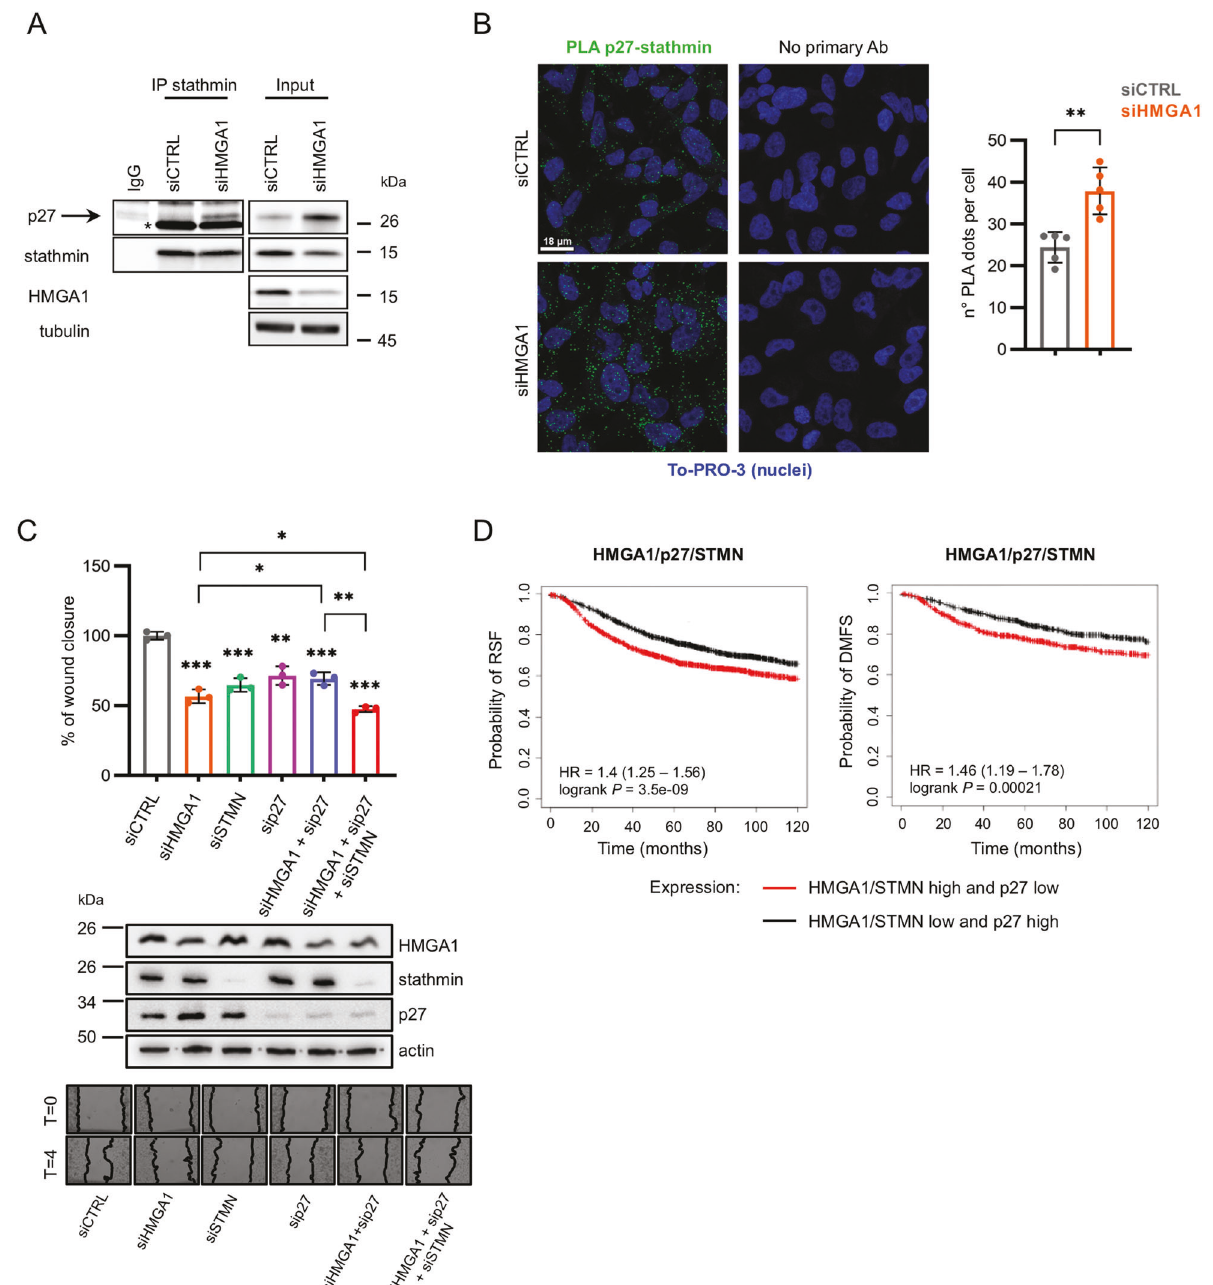
Fig. 5 HMGA1/p27/stathmin axis regulates migration in MDA-MB-231 cells. A Lysates from MDA-MB-231 cells transfected with siCTRL and siHMGA1 were immunoprecipitated with stathmin and non-speci fi c IgG antibodies. The amount of co-immunoprecipitated p27 is visualized by western blot analysis (the speci fi c band is indicated by the arrow). The asterisk indicates the aspeci fi c band due to the presence of immunoglobulines. Inputs are shown on the right. B p27-stathmin proximity was measured by in situ PLA in MDA-MB-231 cells transfected with siCTRL and siHMGA1. In situ PLA is indicated by green signals of the rolling cycle ampli fi cation products. Nuclei (blue) were counterstained using TO-PRO-3. Scale bar, 18 μ M. Quanti fi cation of the number of fl uorescent puncta per cell is shown on the right ( n = 5 different fi elds). ** P < 0.01; two-tailed Student ’ s t -test. C Quanti fi cation of wound-healing assay performed in MDA-MB-231 cells upon silencing of HMGA1 (siHMGA1), stathmin (siSTMN) and p27 (sip27). The results are presented as the mean of percentage of the wound closure relative to control ( n = 3). * P < 0.05, ** P < 0.01, *** P < 0.001; two-tailed Student ’ s t -test. A representative western blot of HMGA1, stathmin and p27 expression after silencing is reported at the bottom of the graph. Representative pictures are reported on the bottom of the panel. D Kaplan – Meier survival curves of Relapse Free Survival (RFS) of 3951 breast cancer patients and Distant Metastasis Free Survival (DMFS) of 1746 BC patients investigated with Kaplan – Meier plotter (KM-plotter, https://kmplot.com/analysis/index.php?p = background) and containing information from GEO, EGA, and TCGA. The data investigated were based on the RNA expression of HMGA1/p27/STMN together (p27 is analyzed in inverted